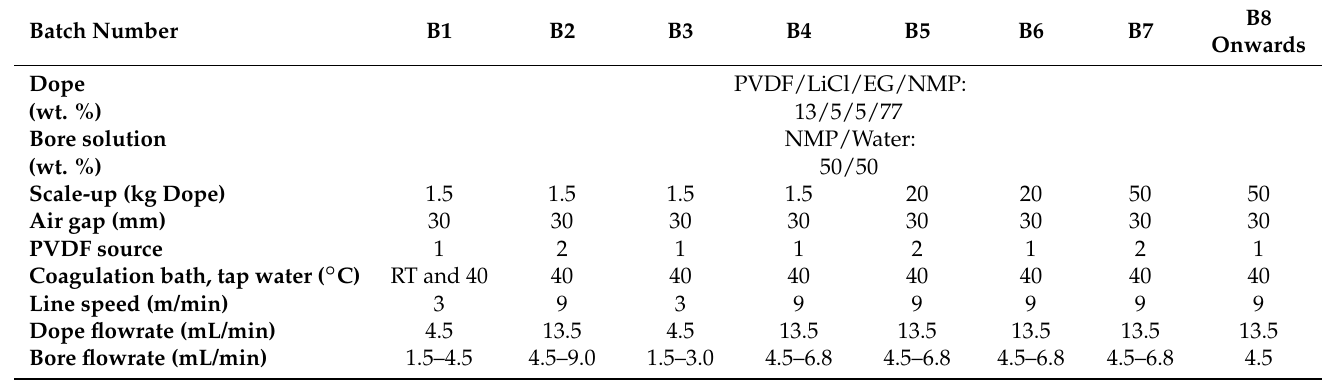
Table 2. Spinning conditions for production of PVDF MD hollow fibers. Based on conditions from Zuo and Chung [28,37]. Design of experiments (DOE) using speed line and coagulation bath temperature as variables. Bore flowrate was adjusted to the DOE parameters.